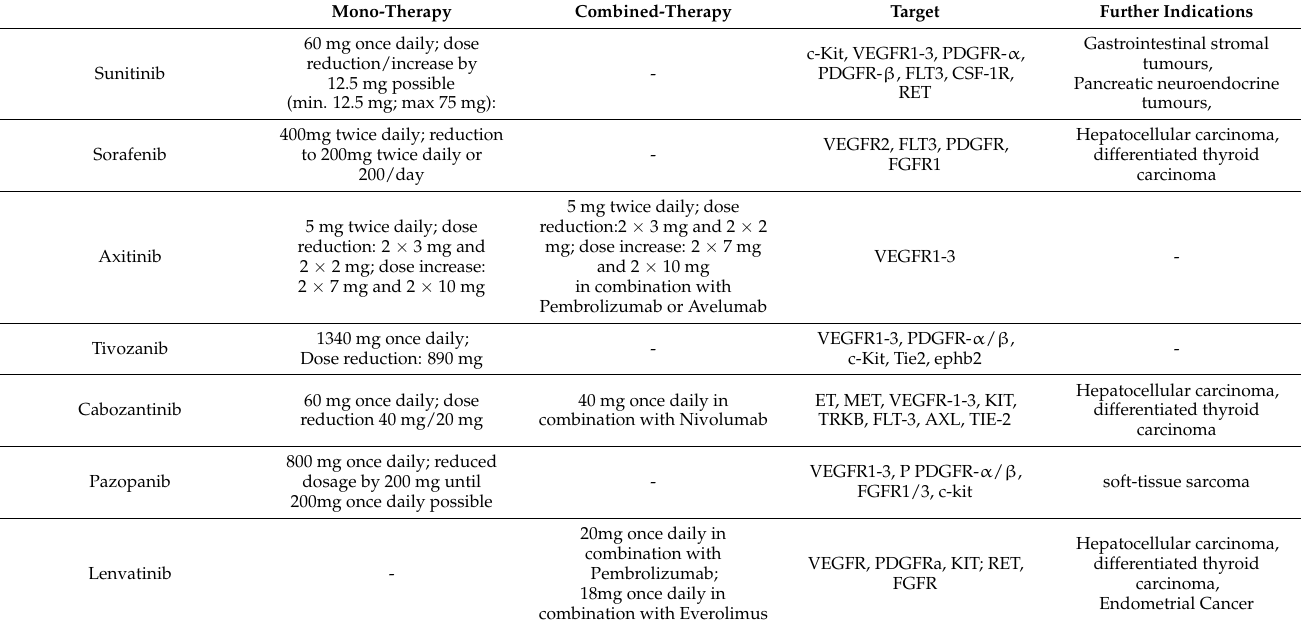
Table 3. List of all tyrosine kinase inhibitors applied to treat renal cell carcinoma, their dosage, and